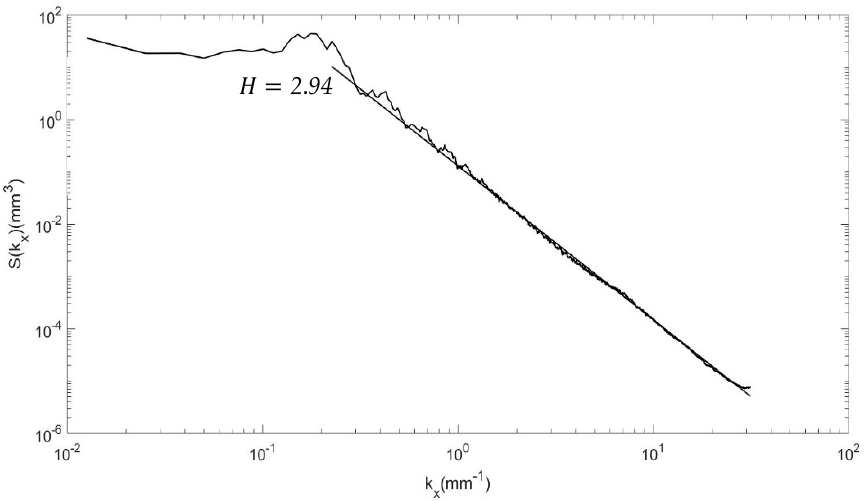
Figure 8. One-dimensional surface roughness power spectral density (PSD) of the artificial gravel riverbed’s surface and a regression line between k 0 and k 1 with slope H , the Hurst